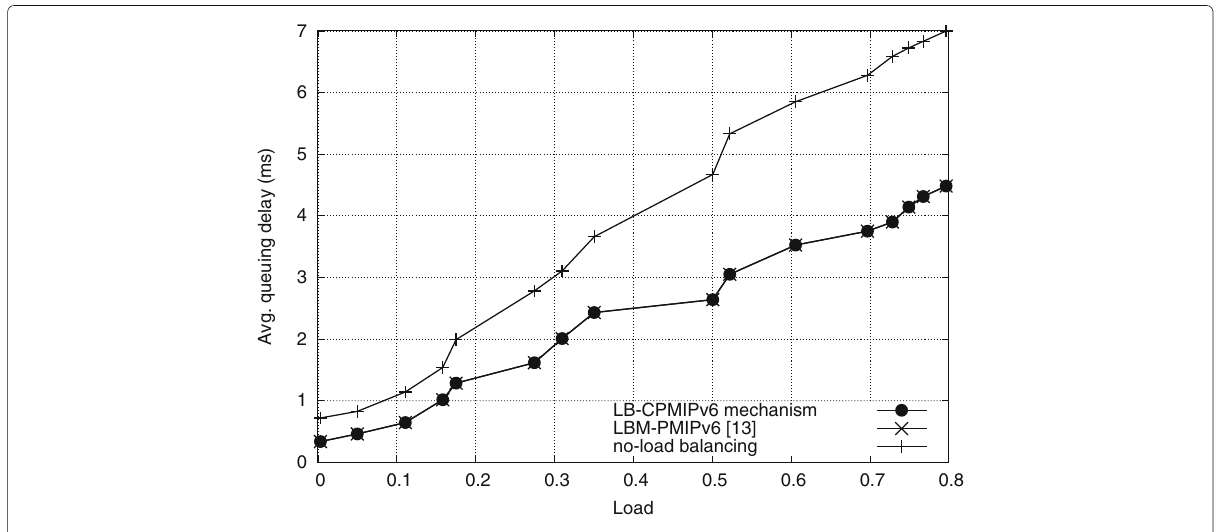
Fig. 12 The average queuing delay per MAG in the PMIPv6 protocol